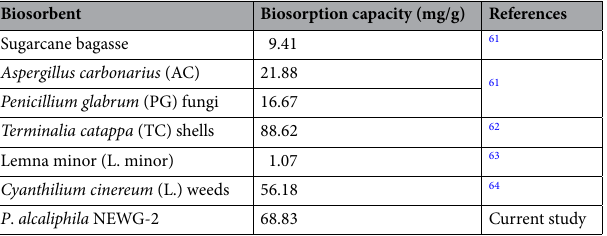
Table 7. The current study of Langmuir biosorption capability compared to that of previous studies.